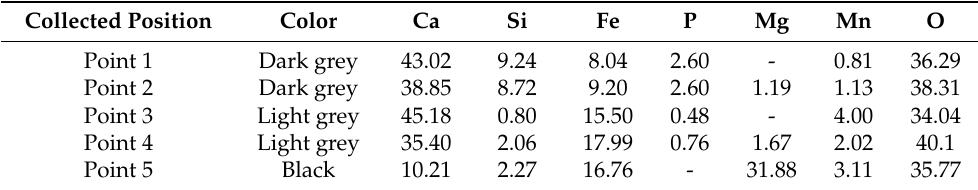
Table 5. EDS analysis results (wt.%) of dephosphorization slag in Heat 2 corresponding to Figure 7.